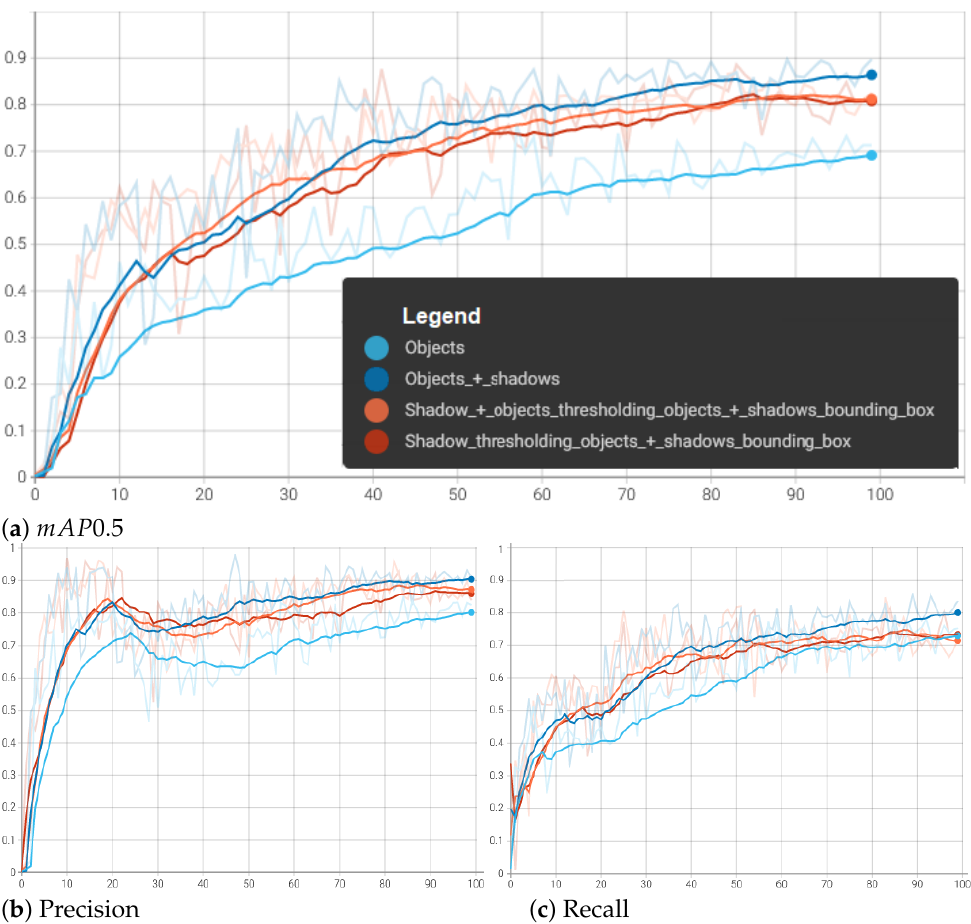
Figure 8. Smoothed metrics’ courses during training for validation dataset of 4 described configura- tions, featuring mean average precision, precision, and recall—defined in Equations (1)–(3).